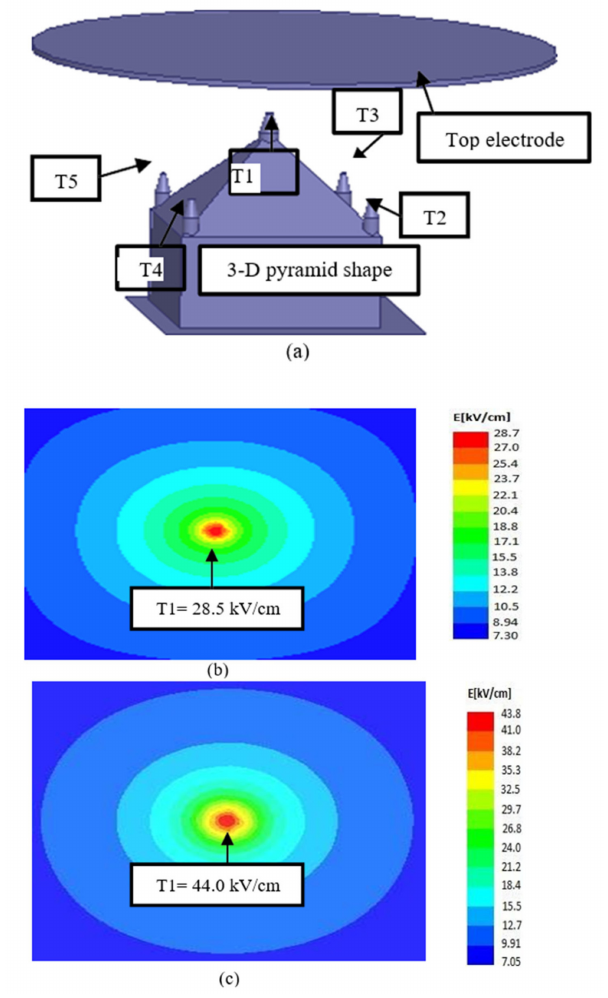
Figure 17. Probability of lightning on a pyramid-shape model: ( a ) 3D model of a pyramid shape ( b ) field plot without upward leaders, ( c ) field plot with upward leaders.